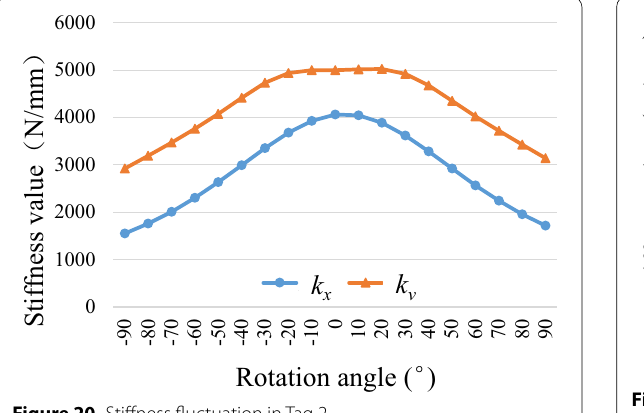
Figure 20 Stiffness fluctuation in Tag 2